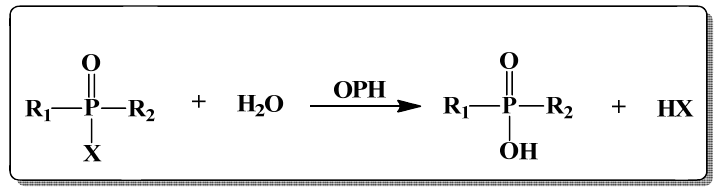
Figure 4. Mechanism for the hydrolysis of OP compounds by